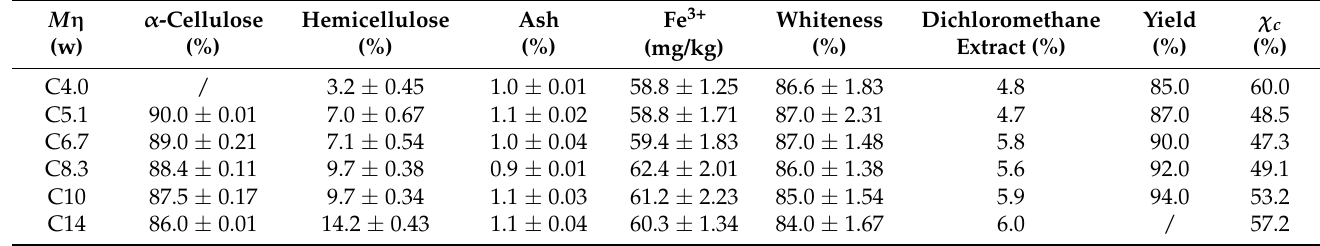
Table 1. The crystallinity and α -cellulose of the prepared bamboo cellulose with different M η .